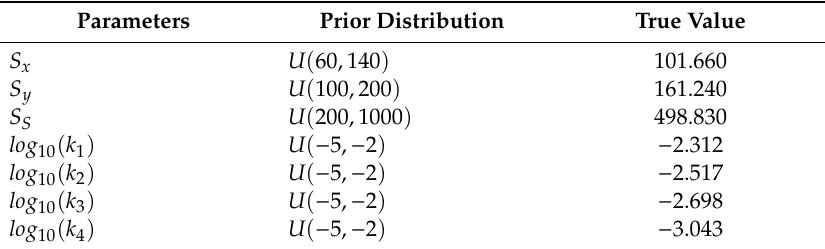
Table 6. The prior distributions and reference true values of the model parameters estimated in Case 3. U stands for the uniform